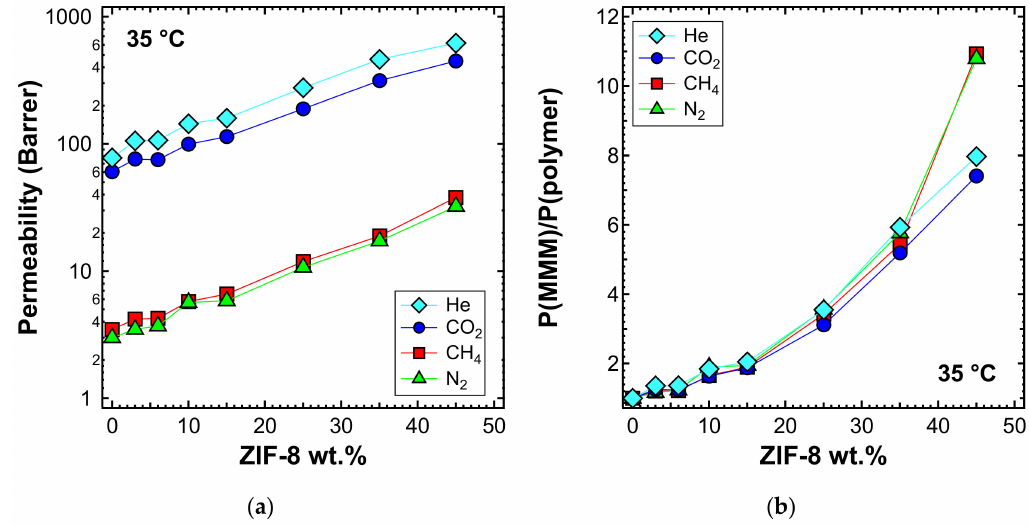
Figure 9. ( a ) Permeability and ( b ) relative permeability increase of various gases at 35 ◦ C with an upstream pressure of 1.3 bar in ZIF-8 / PPO MMMs.